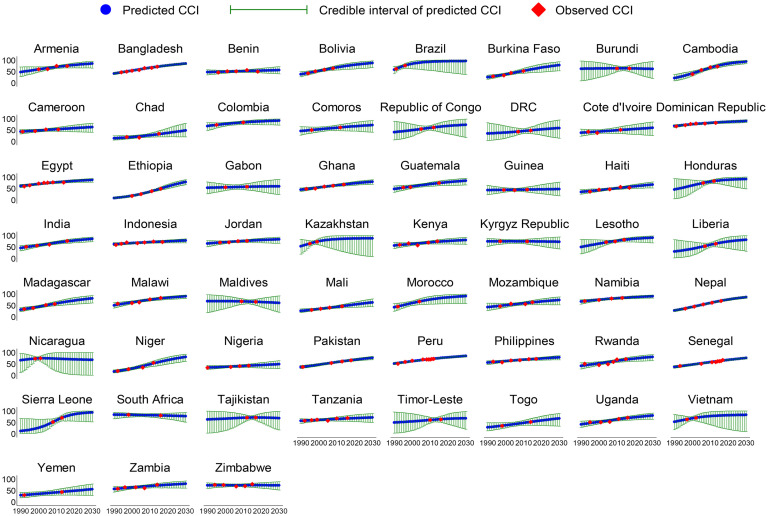
Progress and Projections of Composite Coverage Index in Low- and Middle-Income CountriesAbbreviation: CCI, composite coverage index.